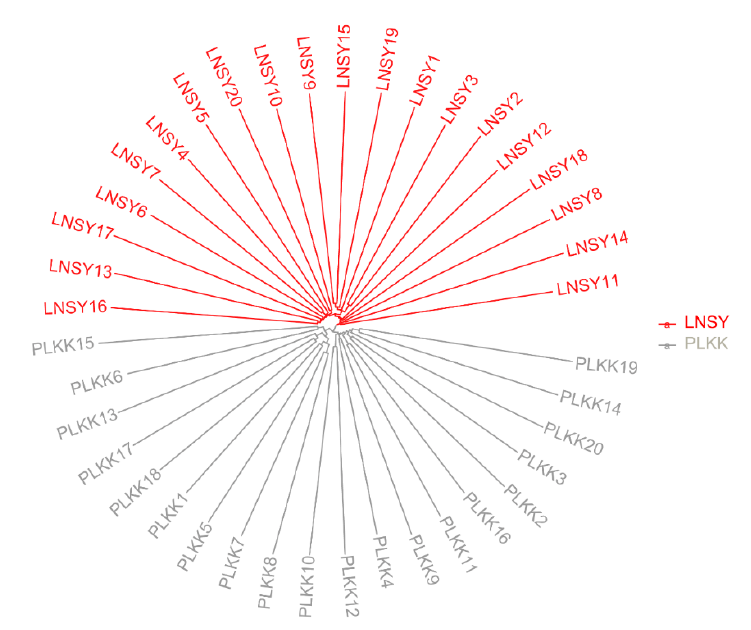
Figure 1. Neighbor-joining phylogram of the LNSY and PLKK populations of H. axyridis . The di ff erent colors represent the individuals from di ff erent populations.